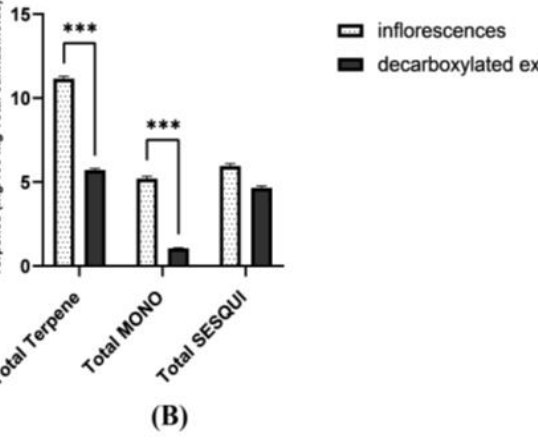
Figure 4. Averaged terpene content of ten inflorescences and of the decarboxylated extracts pro- duced from them, presented as milligrams of each terpene per 100 mg total cannabinoids content. ( A ) Averaged data per each terpene. ( B ) Averaged data for total terpene content, total monoterpene and monoterpenoid content (total MONO), and total sesquiterpene and sesquiterpenoid content (total SESQUI) (see Supplementary data for further details). As seen, while the content of sesquiterpenes and sesquiterpenoids is largely kept in the formed extracts, monoterpenes are completely or mostly lost. Asterisks denote significance level. * p < 0.05, ** p < 0.01, *** p < 0.001. Error Bars denote SEM. To summarize these results, comparing commercial cannabis inflorescences to com- lower total amount of terpenes was found in the latter and a much-reduced fraction of the tions were found when directly comparing inflorescences to decarboxylated extracts pro- duced from them. Future studies should further address potential differences in bioactive components, other than terpenes, such as flavonoids. This deficiency in terpenes of the oils, particularly in that of monoterpenes and mon- oterpenoids, may have major implications. This is since terpenes have therapeutic